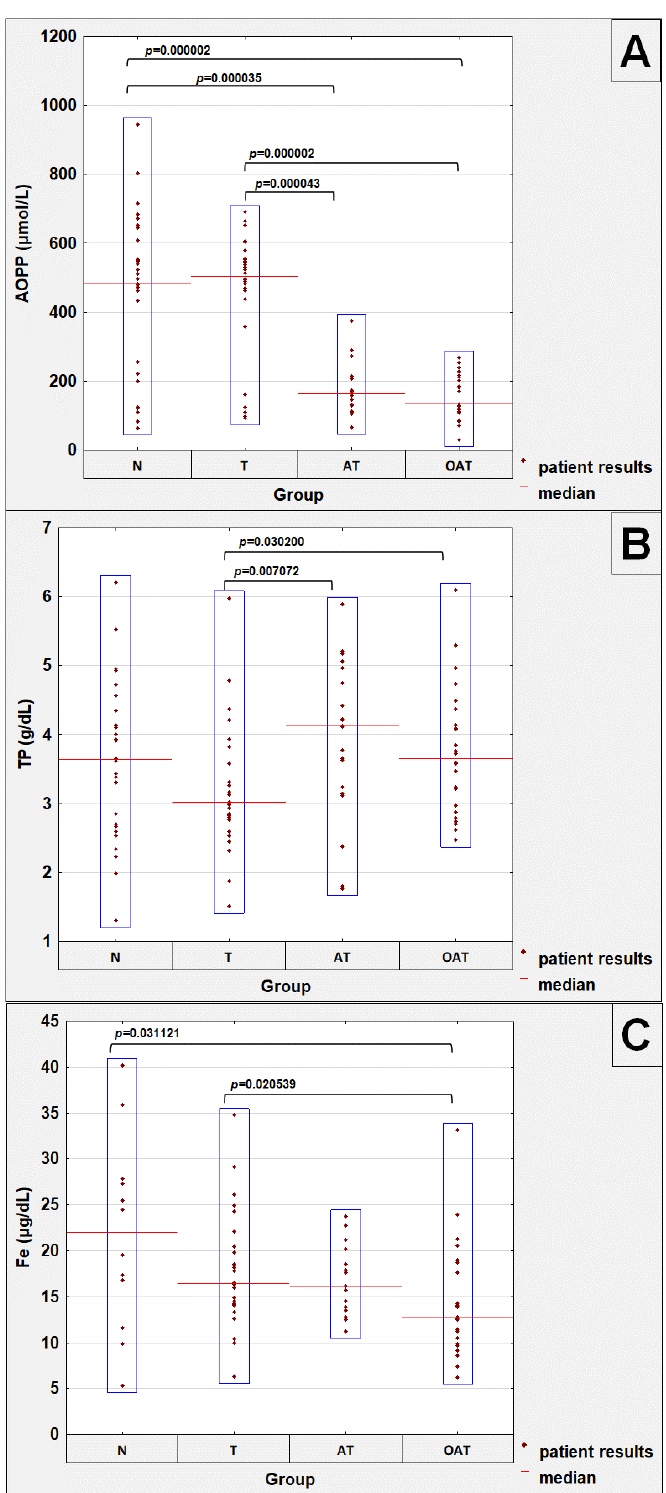
Figure 1. Concentration values of selected seminal plasma parameters which significantly differentiated examined groups of patients: AOPP—advanced oxidation protein products ( A ), TP—total protein ( B ), Fe—iron ( C ). N—normozoospermia, T—teratozoospermia, AT—asthenoteratozoospermia, OAT—oligoasthenoteratozoospermia. All patient results in a given group are gathered in the blue boxes. A two-tailed p -Value < 0.05 was considered significant.